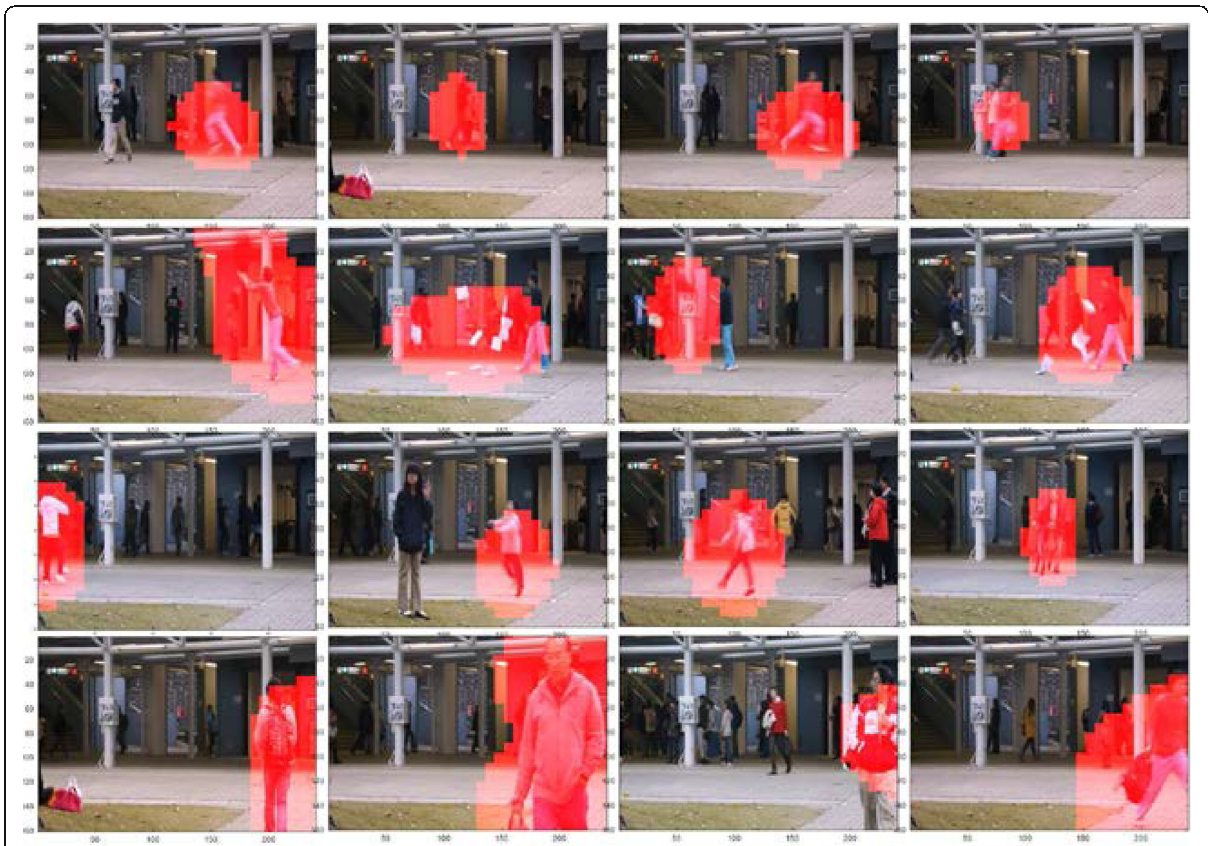
Fig. 11 Examples of detection results on the Avenue